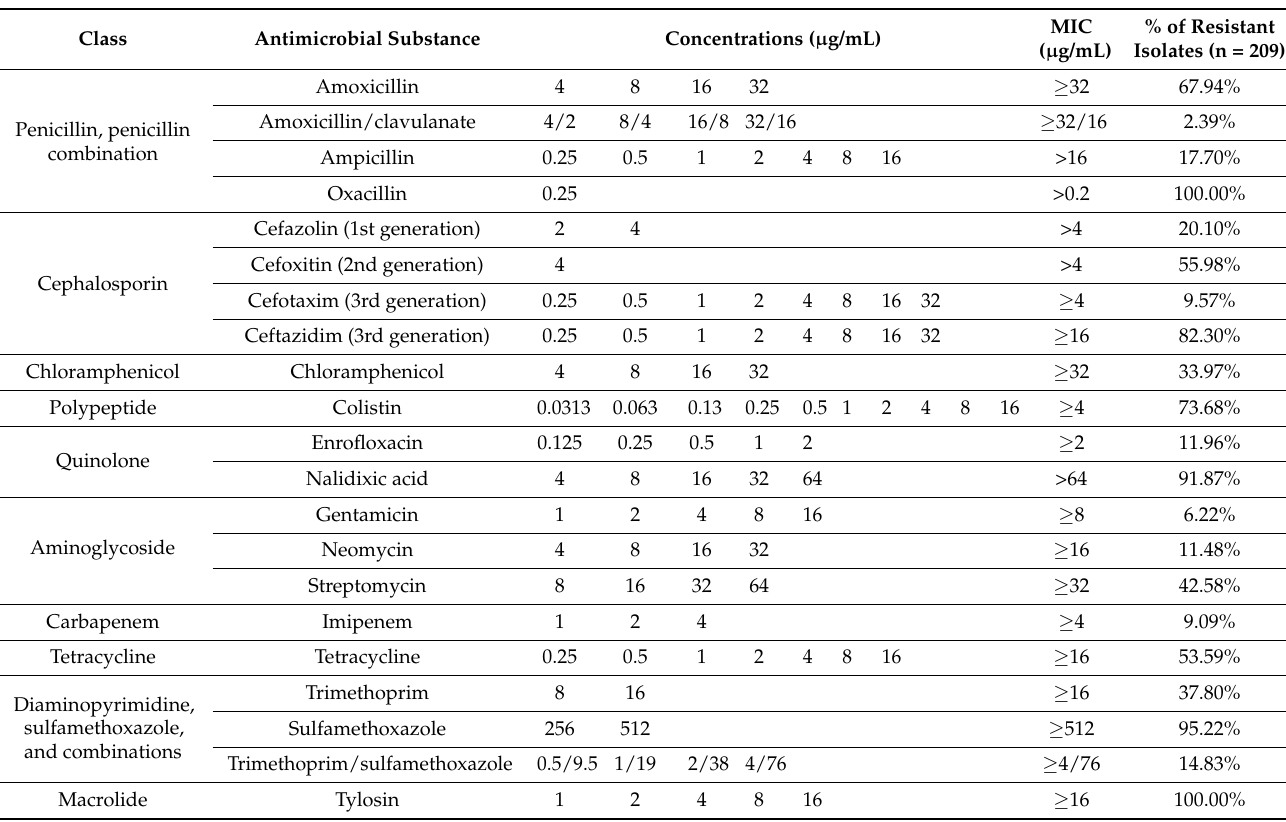
Table 3. Antimicrobial substances and concentrations used for AMR testing, respective minimal inhibitory concentration for resistance (MIC, µ g/mL), and the percentage of resistant isolates based on the given MIC.